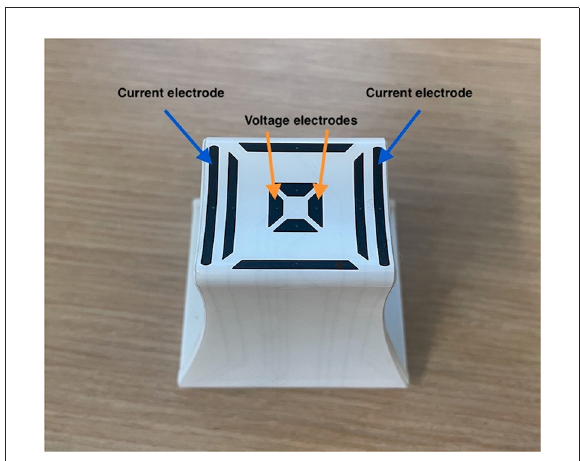
FIGURE1 Electrode array used to obtain data. The outer electrodes (blue arrows) emit the electrical current and the inner electrodes (orange arrows) measure the resulting